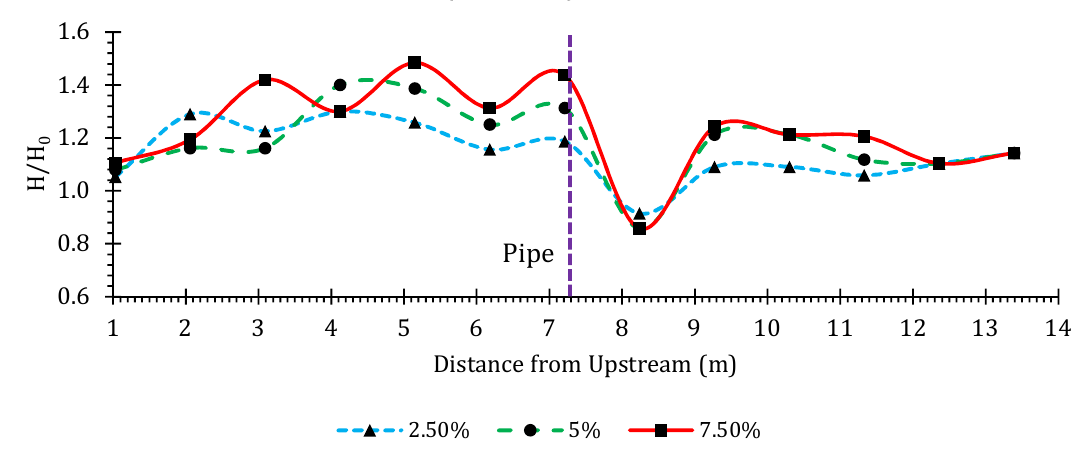
Figure A27. Water height ratios in a 90° junction for Fr = 0.95 in the narrow channel.